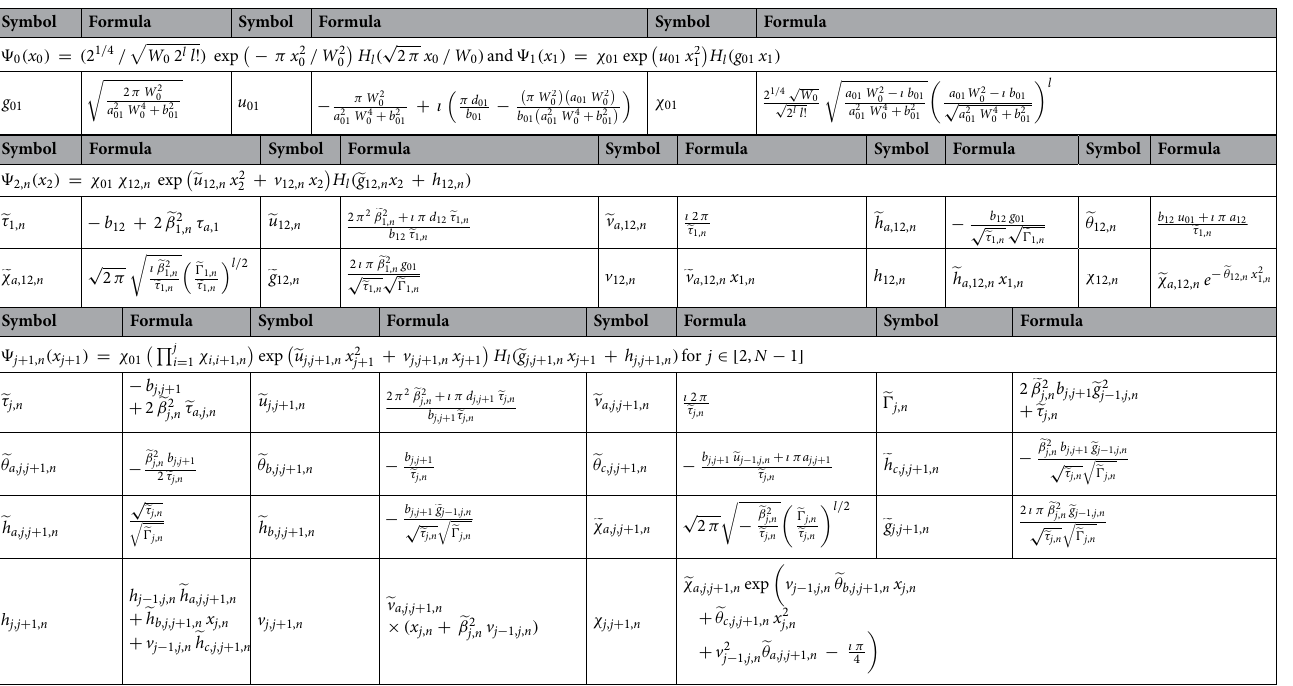
( a , b , c , d ) LCT for Hermite-Gaussian